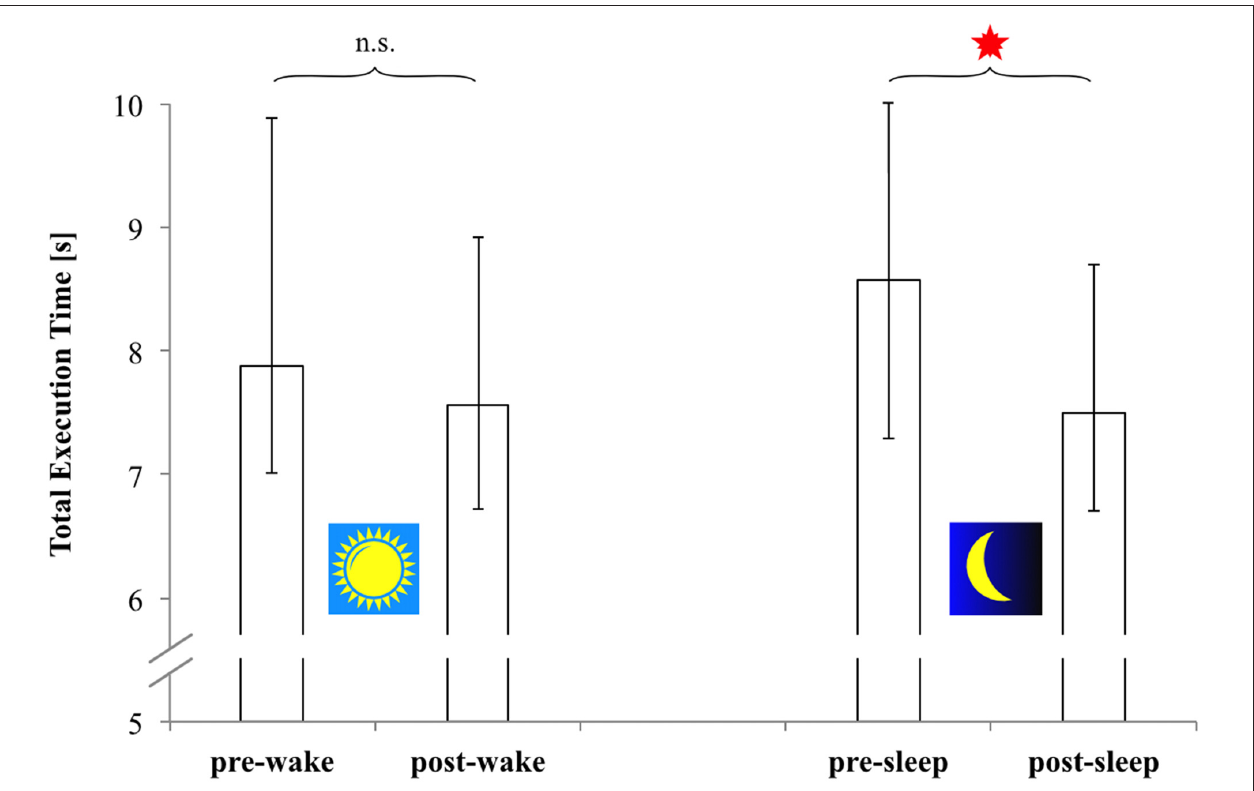
FIGURE 3 | Total execution time (seconds; correct sequences only) of all 18 subjects (Morning-Evening-Morning-group and Evening-Morning-Evening-group combined) at free recall . Presented are measures based on the combined data from both groups’ pre- and post-wake retention tests (left panel), and from both groups’ pre- and post-sleep retention tests (right panel). Open bars: medians; Error bars: upper and lower quartiles. ∗ Significant difference of group medians ( p =